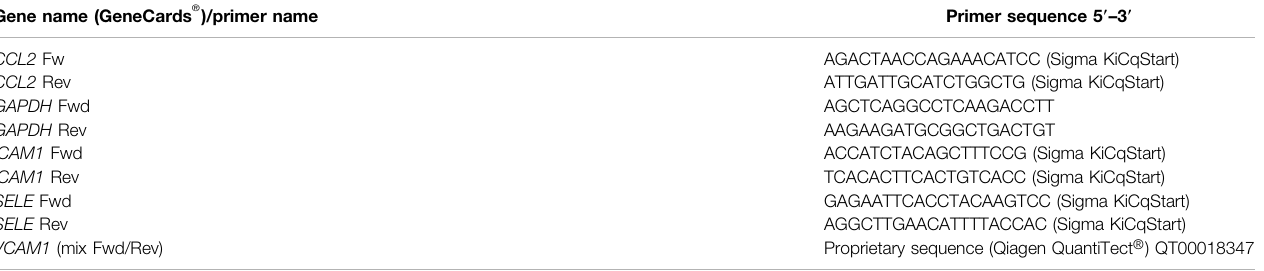
TABLE 1 | Primers used for quantitative